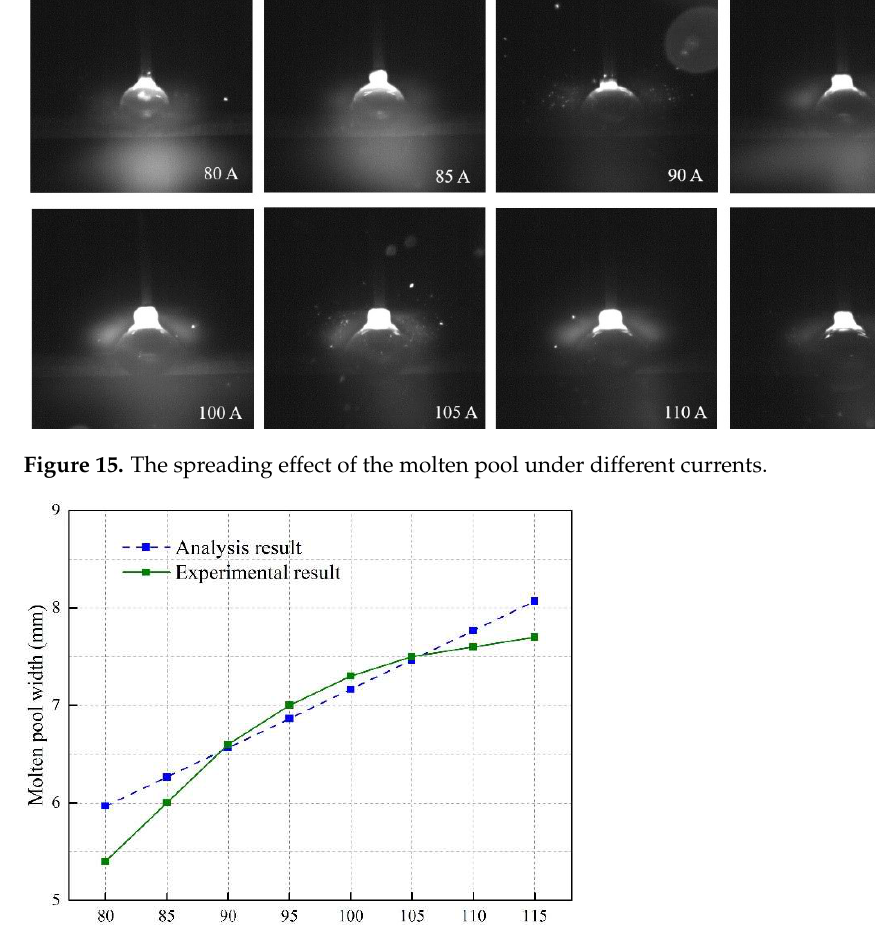
Figure 16. The changing trend of the spreading width of the molten pool.